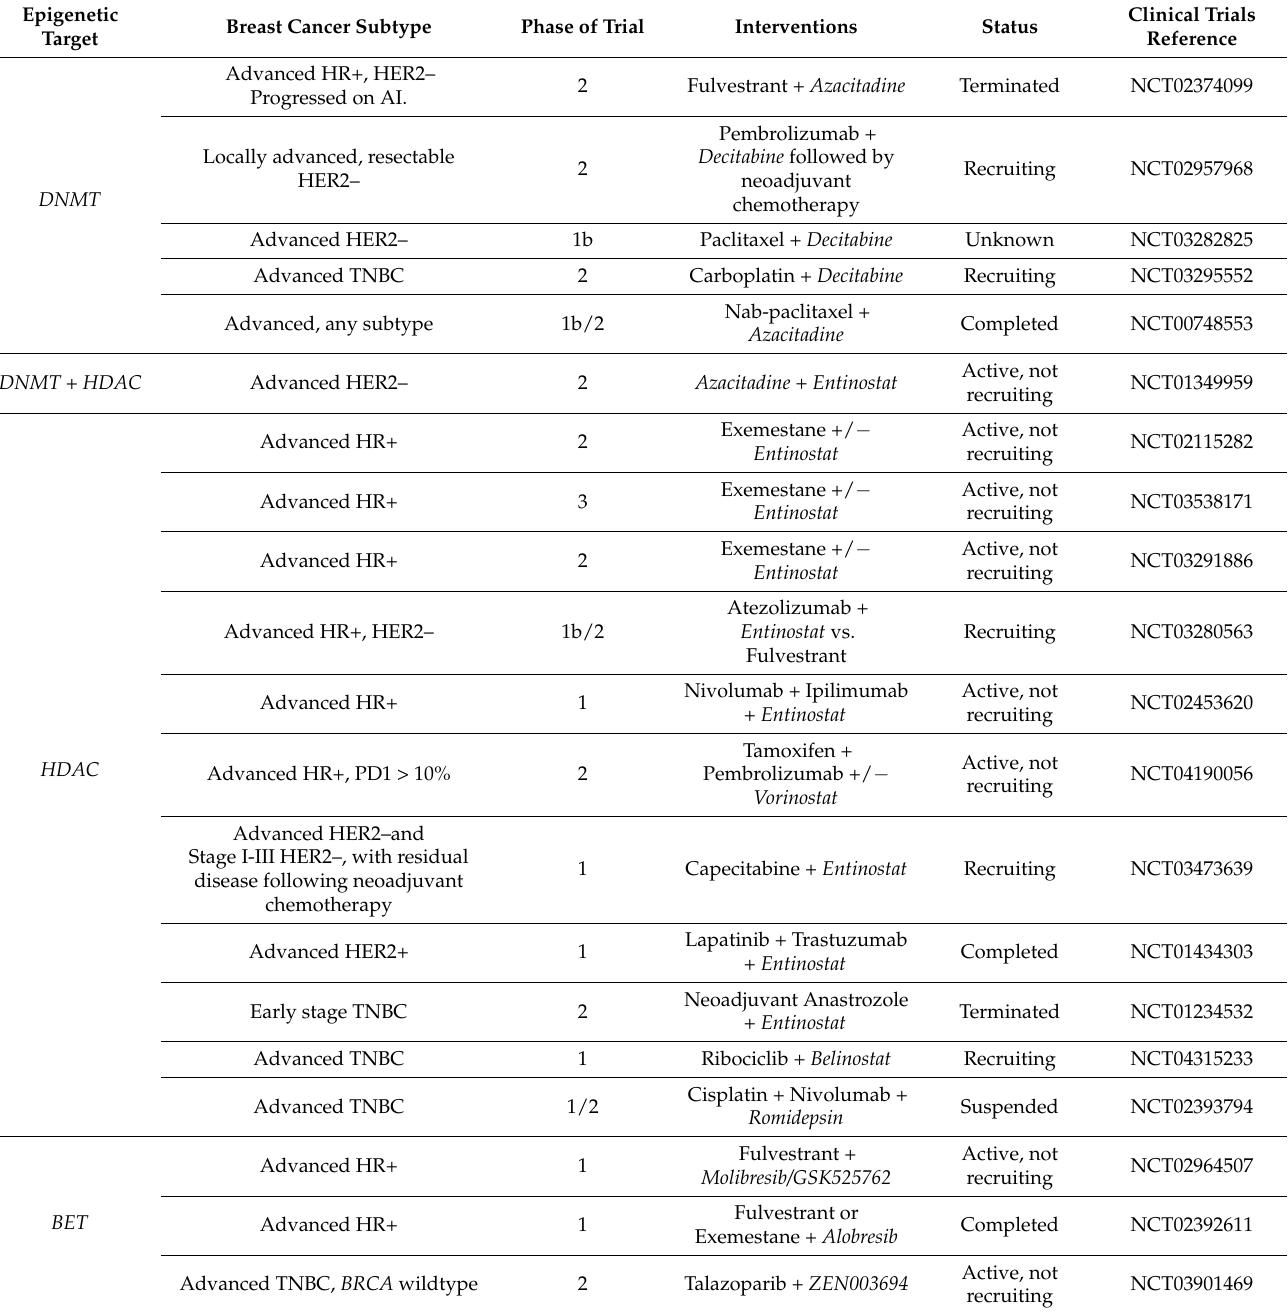
Table 2. Summary of Epigenetic therapy trials in-progress for Breast